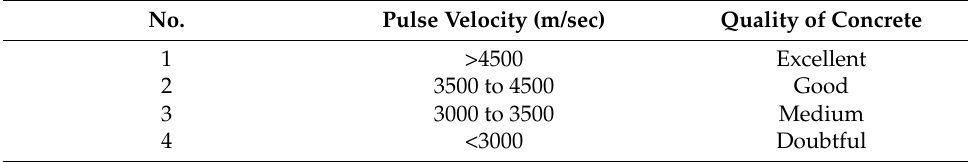
Table 5. Velocity criterion for concrete